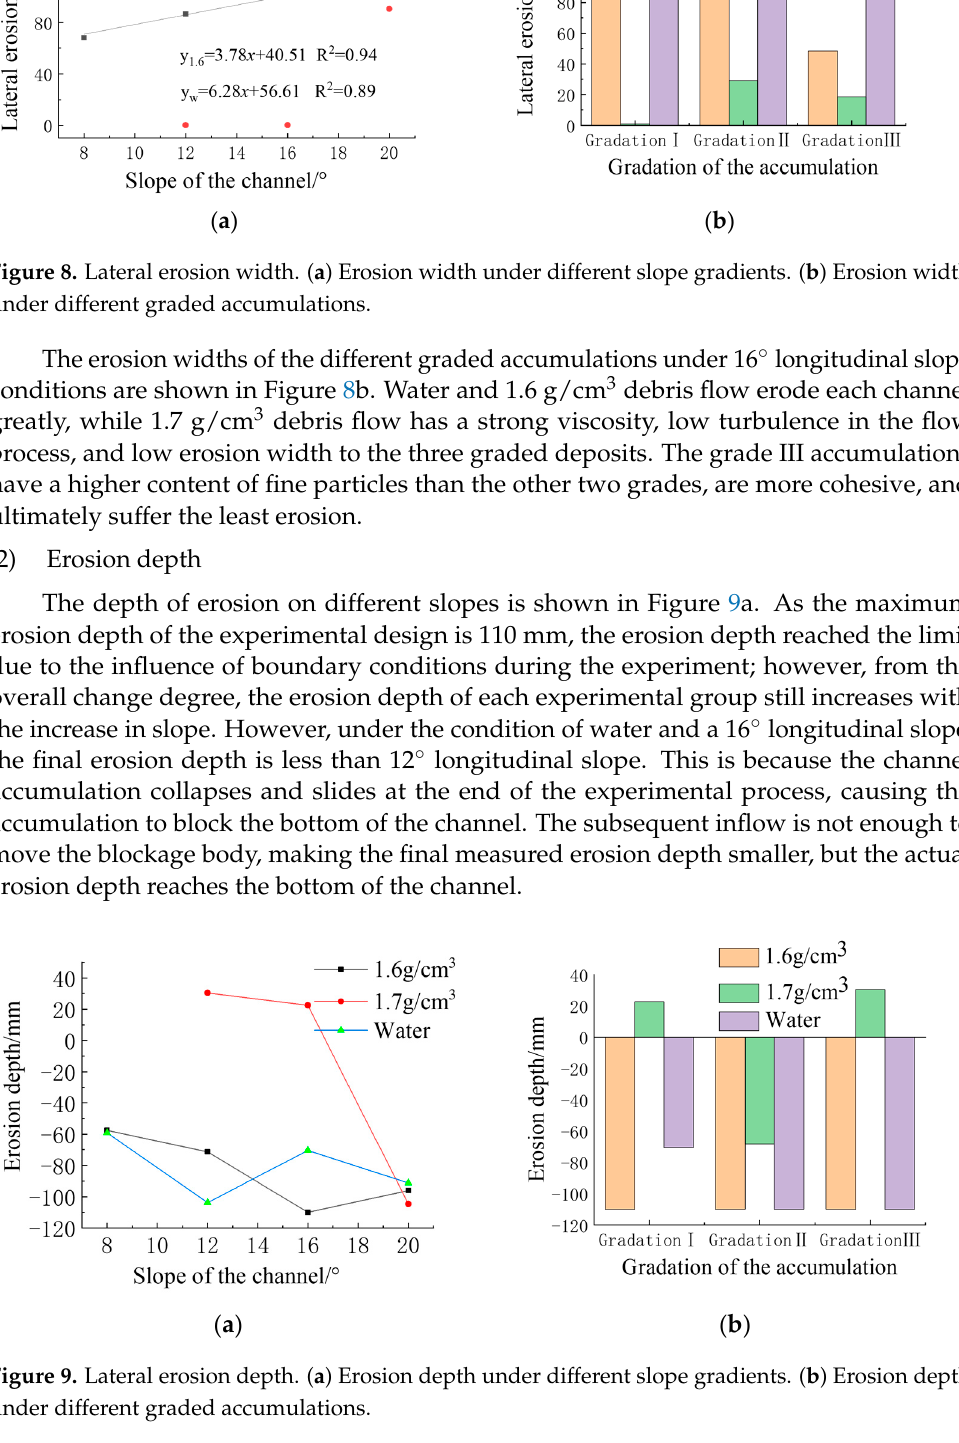
viscosity has a greater influence on the erosion width.